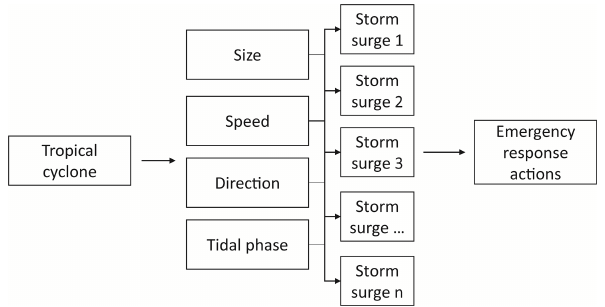
Figure 6. Elements that make up a spatially compounded surge haz- ard, as described in this study (see Zscheischler et al.,